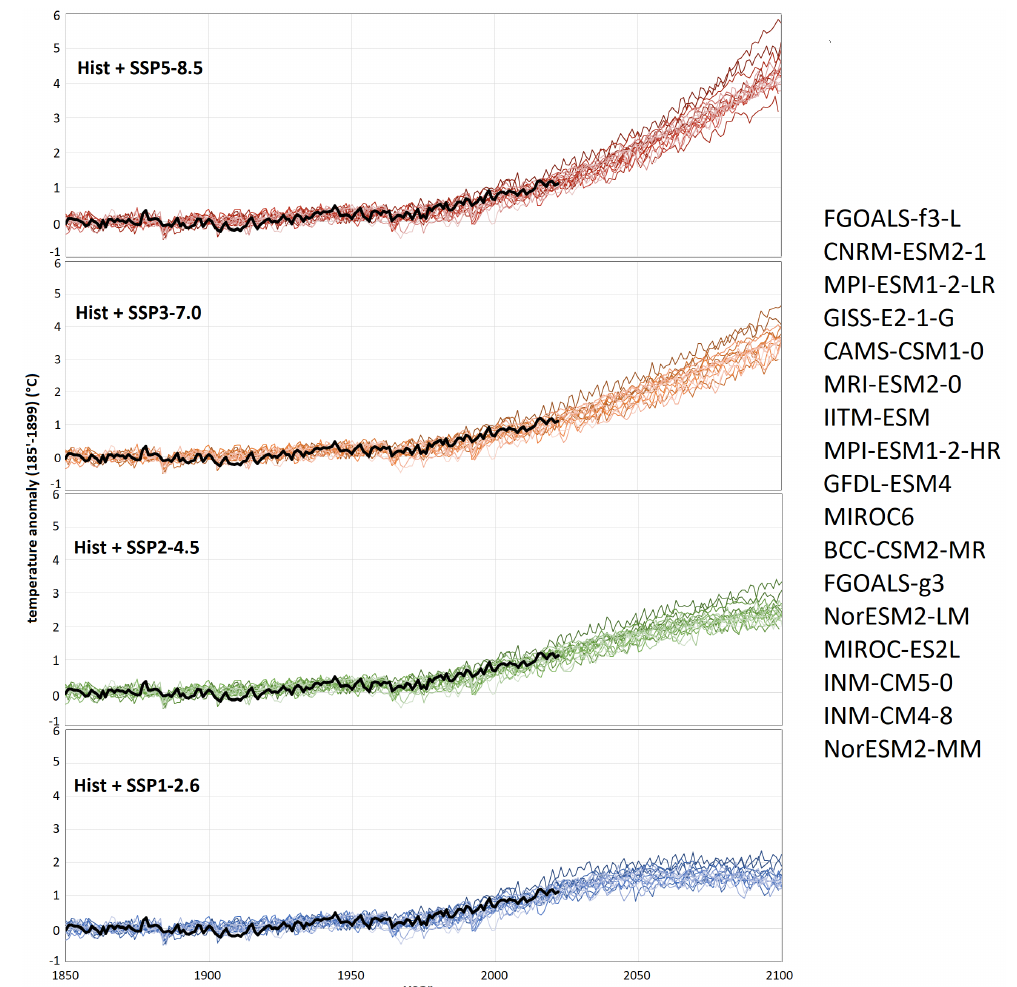
Figure 6. Selection of 17 average computer simulations of the CMIP6 Global Circulation Models (GCMs) using historical + SSP forcing functions. The GCM list and the color gradients of the curves go from low-TCR (light color) to high-TCR (dark color). The HadCRUT5 global surface temperature (non-infilled) record is in black [22]. See Table